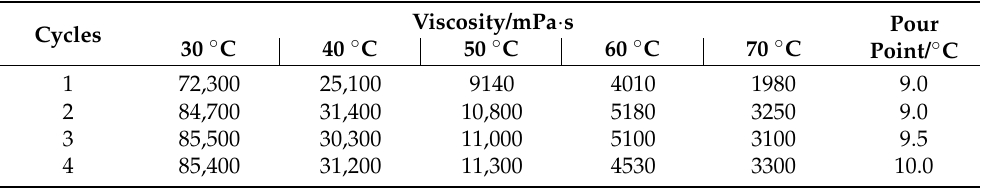
Table 3. The viscosity of heavy oil after different cycles.